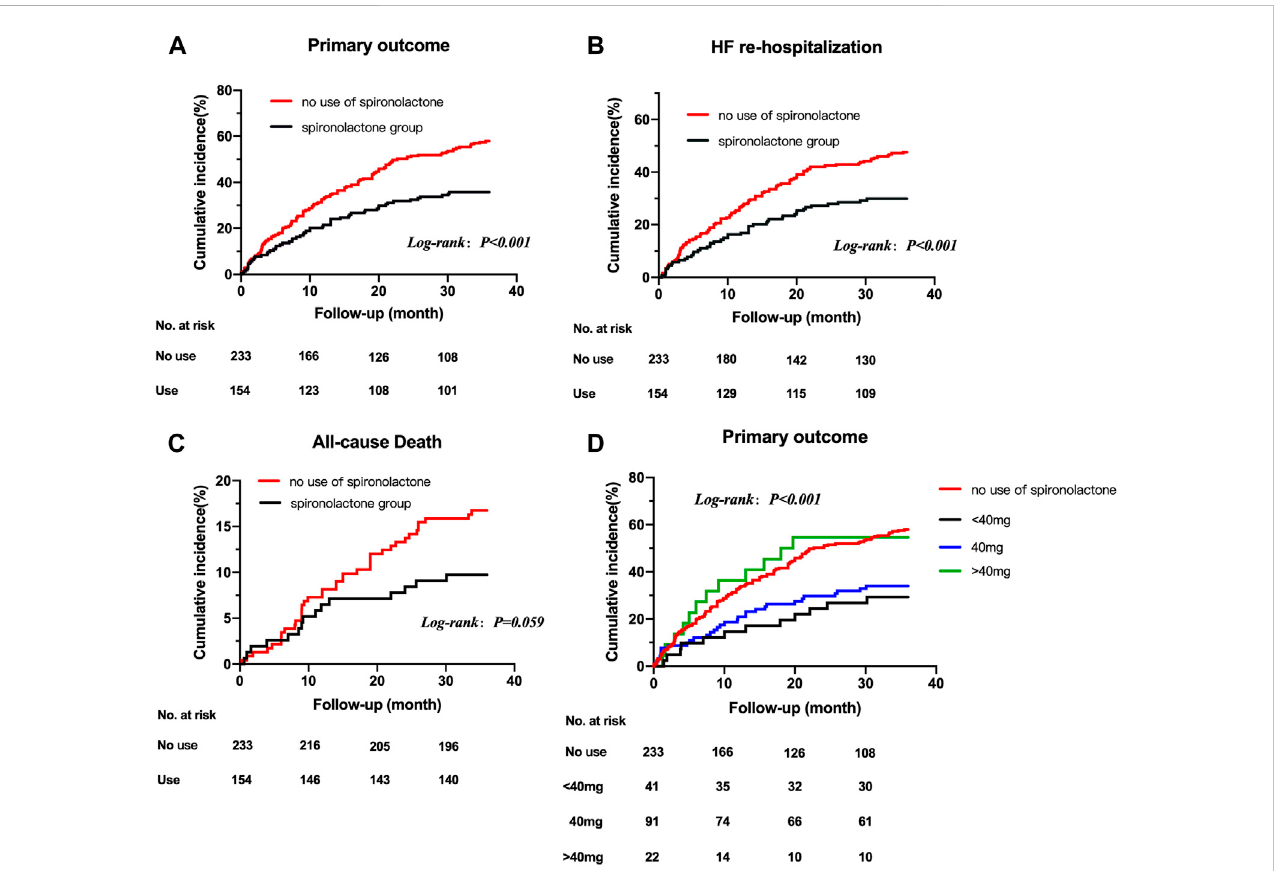
Title: Kaplan-Meier survival curves for outcomes in HFpEF patients with CKD taking and not taking spironolactone Legend: Kaplan-Meier survival curves for outcomes in HFpEF patients with CKD taking and not taking spironolactone. Rates of freedom from primary outcome events (A) HF re-hospitalization (B) all-cause death (C) and primary outcome events grouped by dose of spironolactone (D) Cumulative incidence of stroke not shown because of the very low number of observations. HFpEF, heart failure with preserved ejection; CKD, chronic kidney